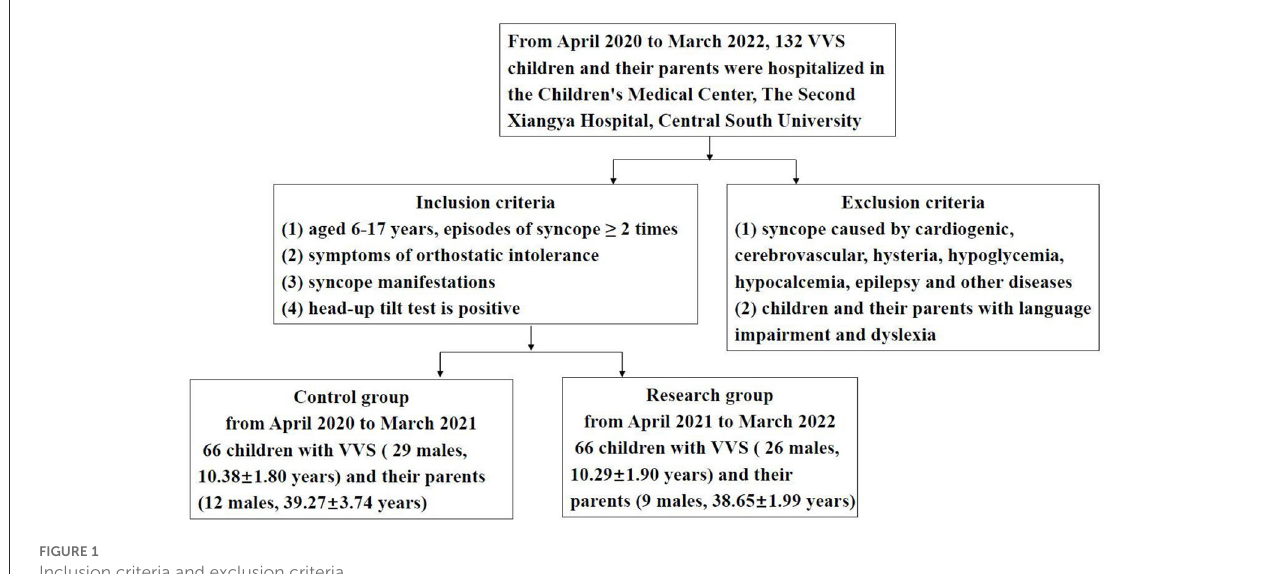
FIGURE1 Inclusion criteria and exclusion criteria.